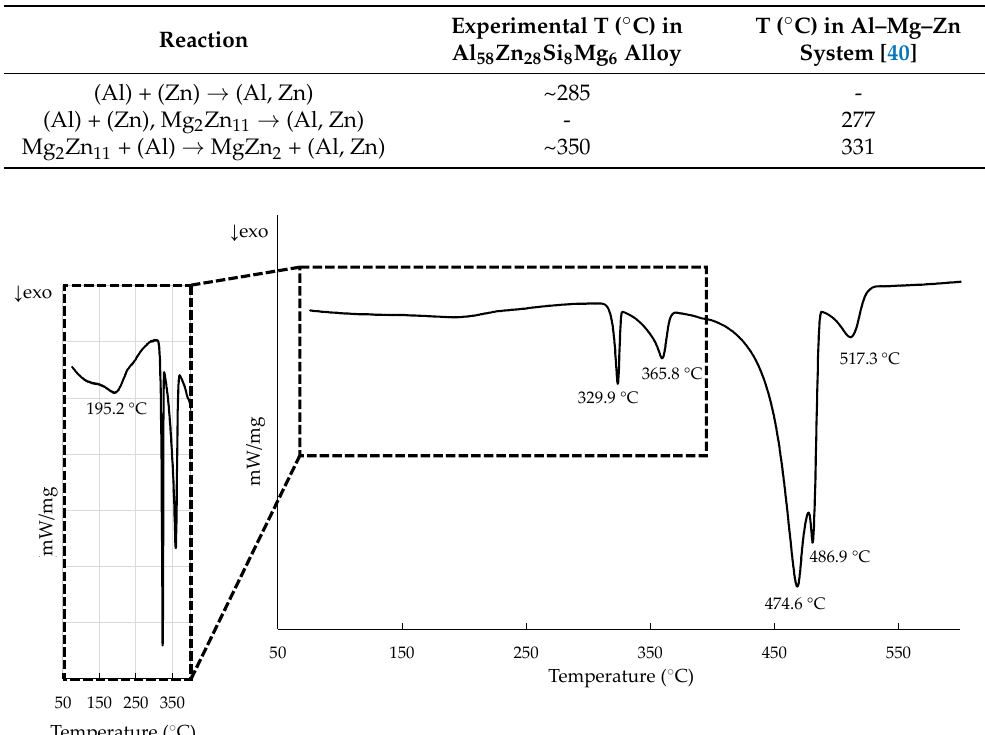
Table 3. Experimental and theoretical temperatures for the reactions observed in the X-ray thermo- diffraction tests.